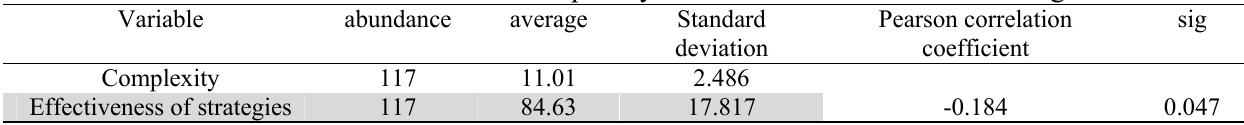
Pearson correlation sig deviation coefficient